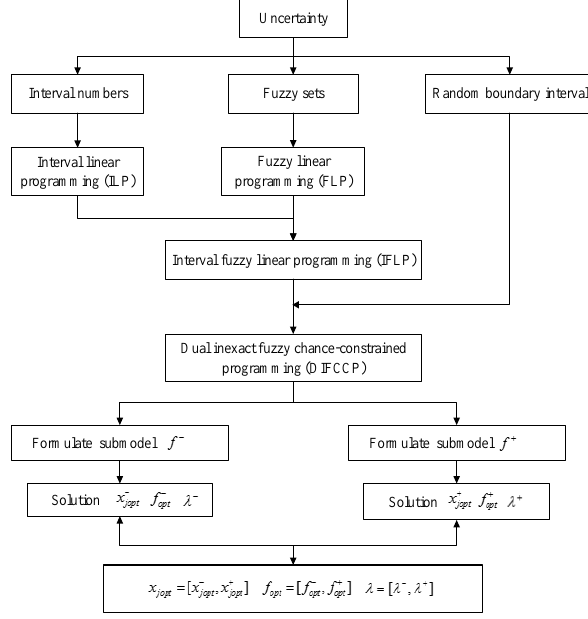
Fig. 1. Optimization method